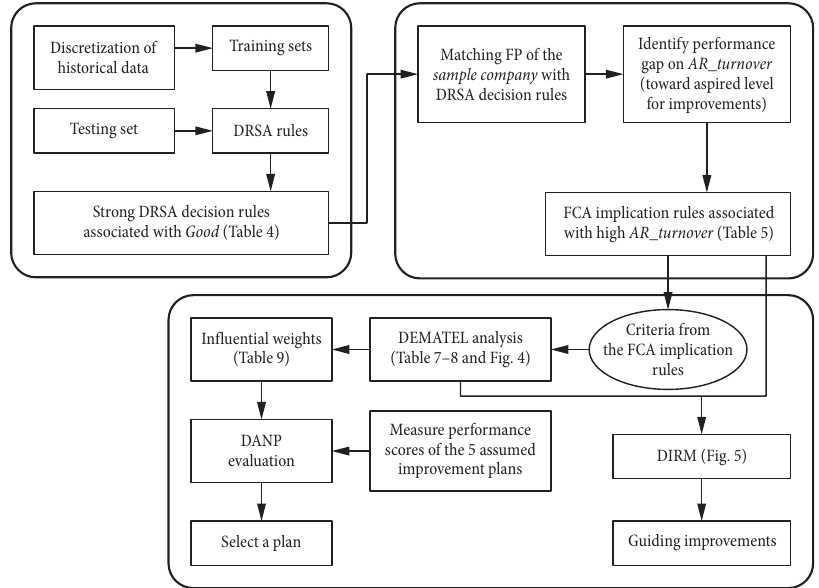
Fig. 2. Illustration of research flows of the empirical case